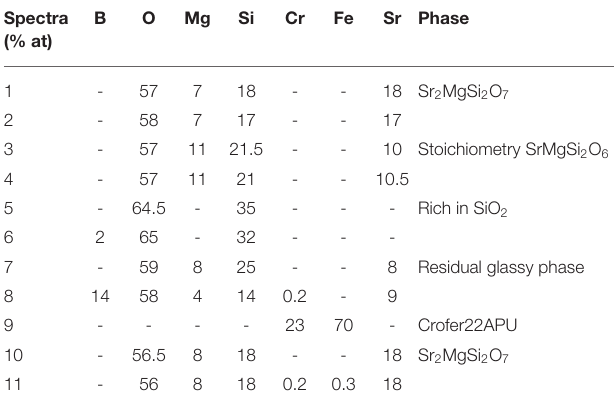
TABLE 5 | Elemental analysis corresponding to Figure 5 . Spectra (%